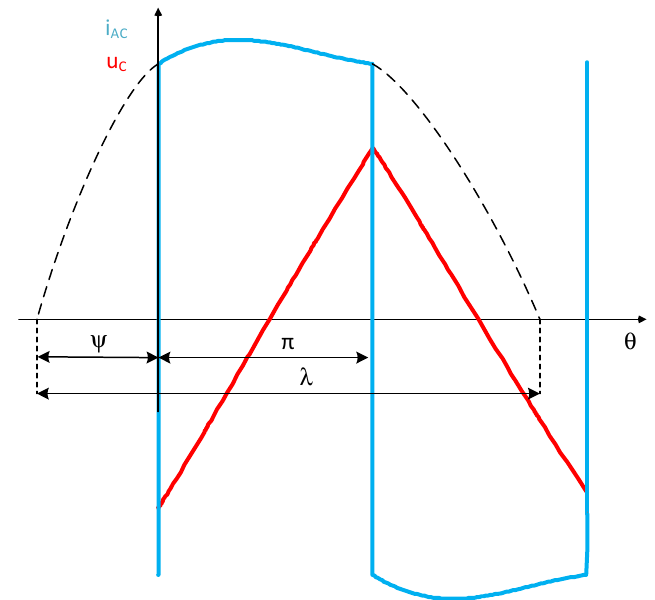
Figure 4. Time diagram of the current in the AC circuit and the voltage on the equivalent series capacitor in a current source inverter.